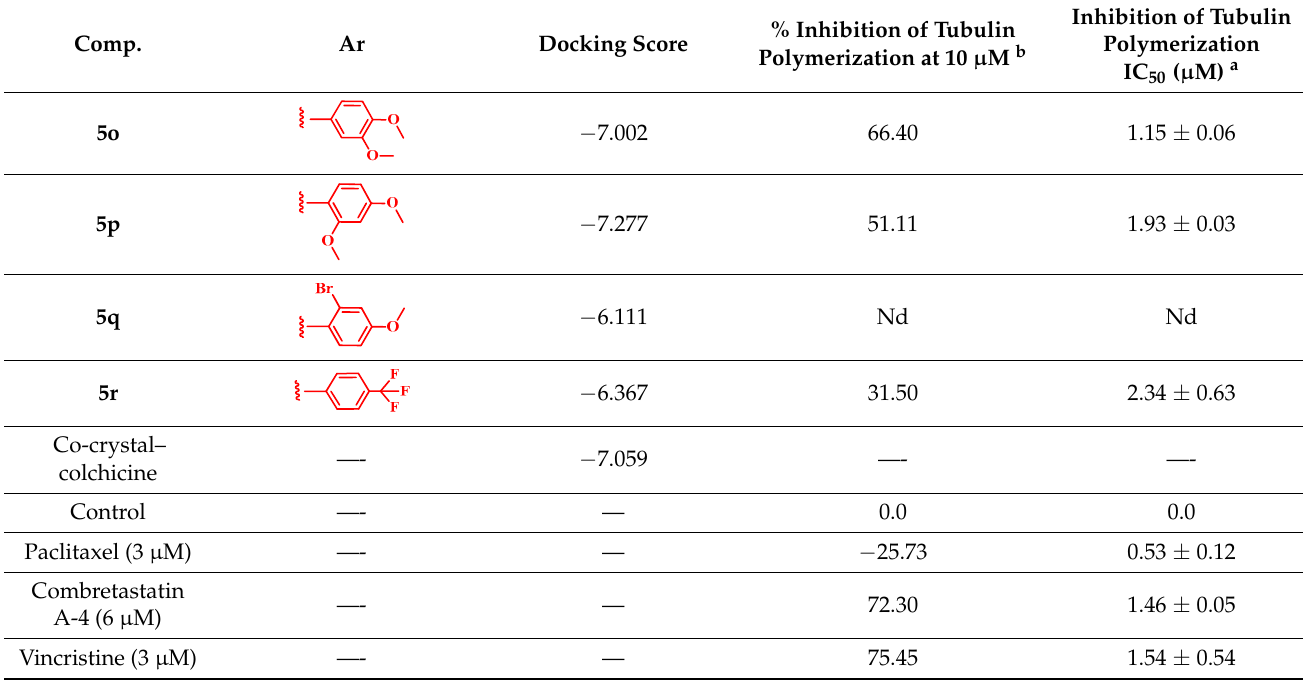
a Half-maximal inhibitory concentration: compound concentration required to inhibit tubulin polymerization by 50%; data are the mean ± SD of n = 3 independent experiments performed in triplicates. b Inhibition of tubulin polymerization at 10 µM (final volume = 10 mL); compounds were pre-incubated with tubulin at a final concentration of 10 µ Μ .